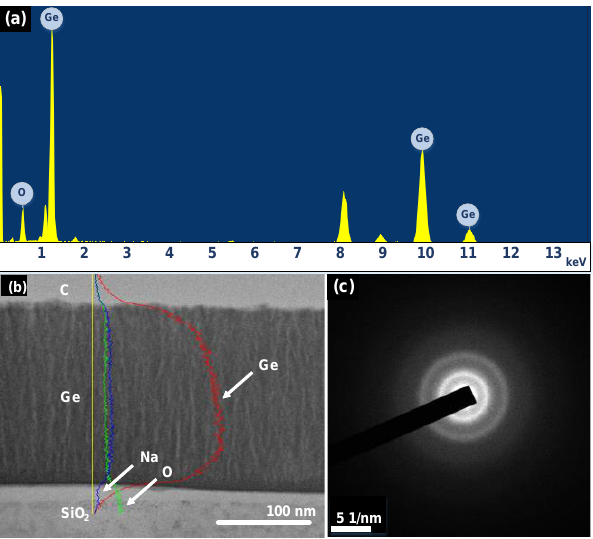
Figure 4. ( a , b ) EDS energy and scanning spectra and ( c ) the SAD pattern of the Ge thin-film.